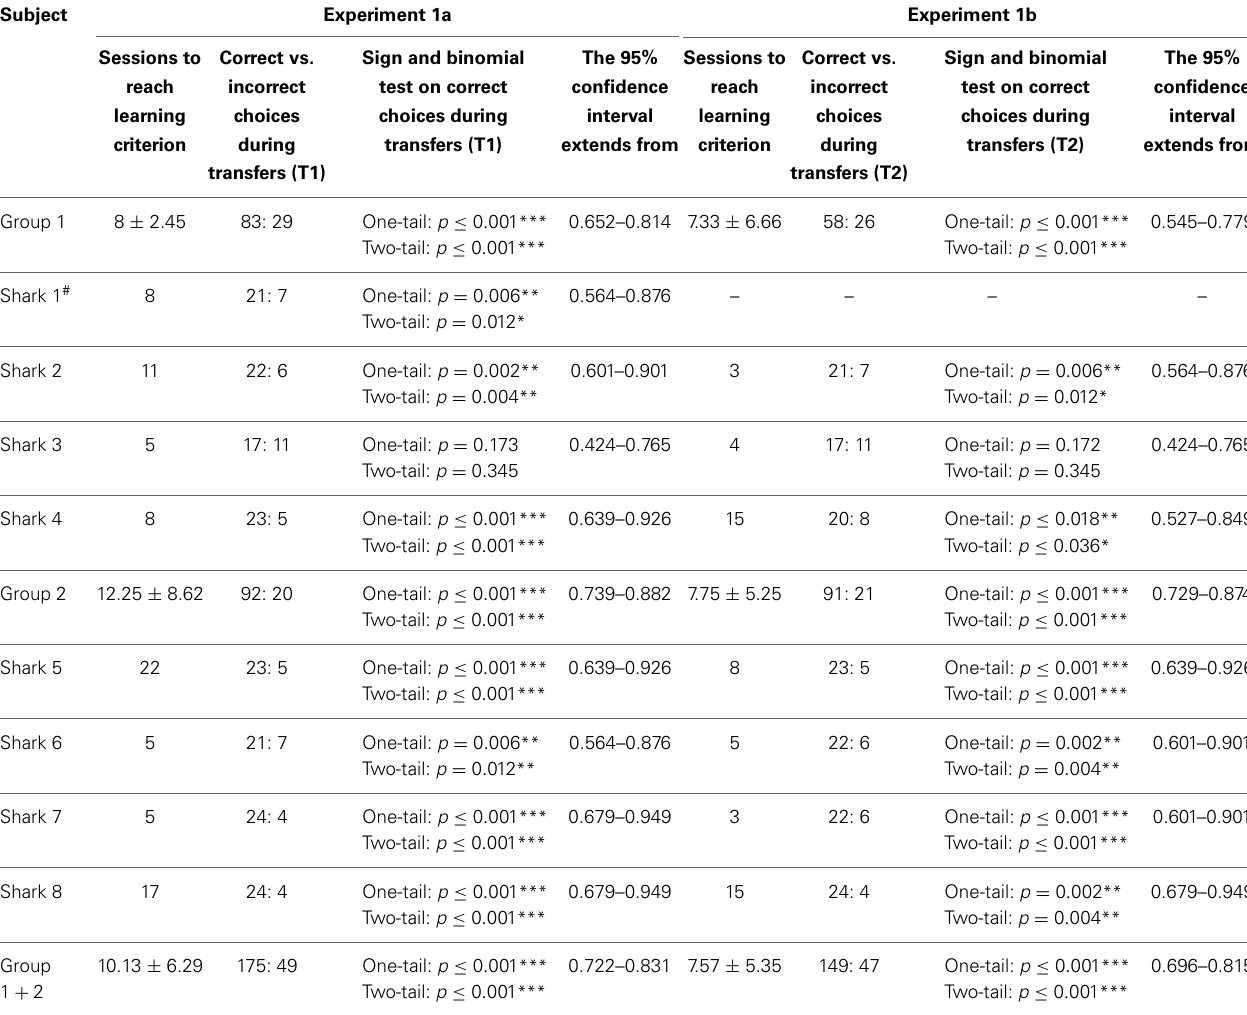
Table 1 | Part 1: Statistics on the performance during regular training trials and transfer tests during Experiment 1: Kanizsa figures (Experiments 1a and